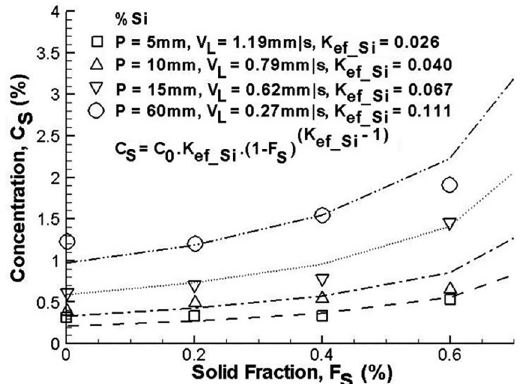
Figure 9. Experimentally measured and calculated microsegregation of the Si solute in the Al-9.0wt%Si-4.0wt%Cu